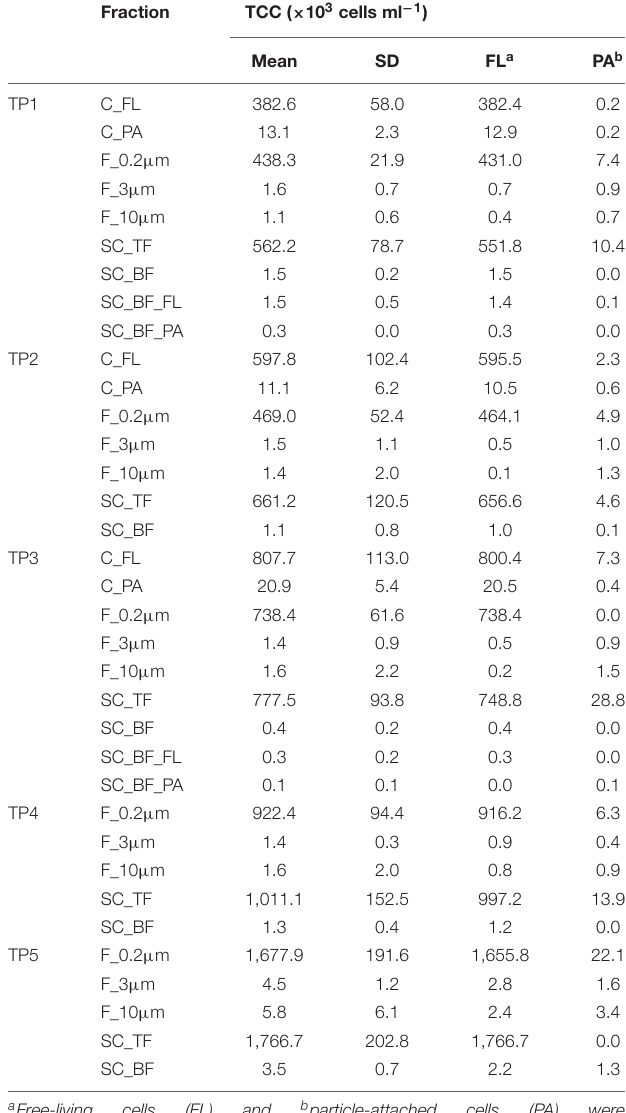
TABLE 1 | Total cell counts (TCC) of seawater fractions, collected during a phytoplankton spring bloom off Helgoland (North Sea) in 2018 (Julian Days 102, 109, 115, 128, and